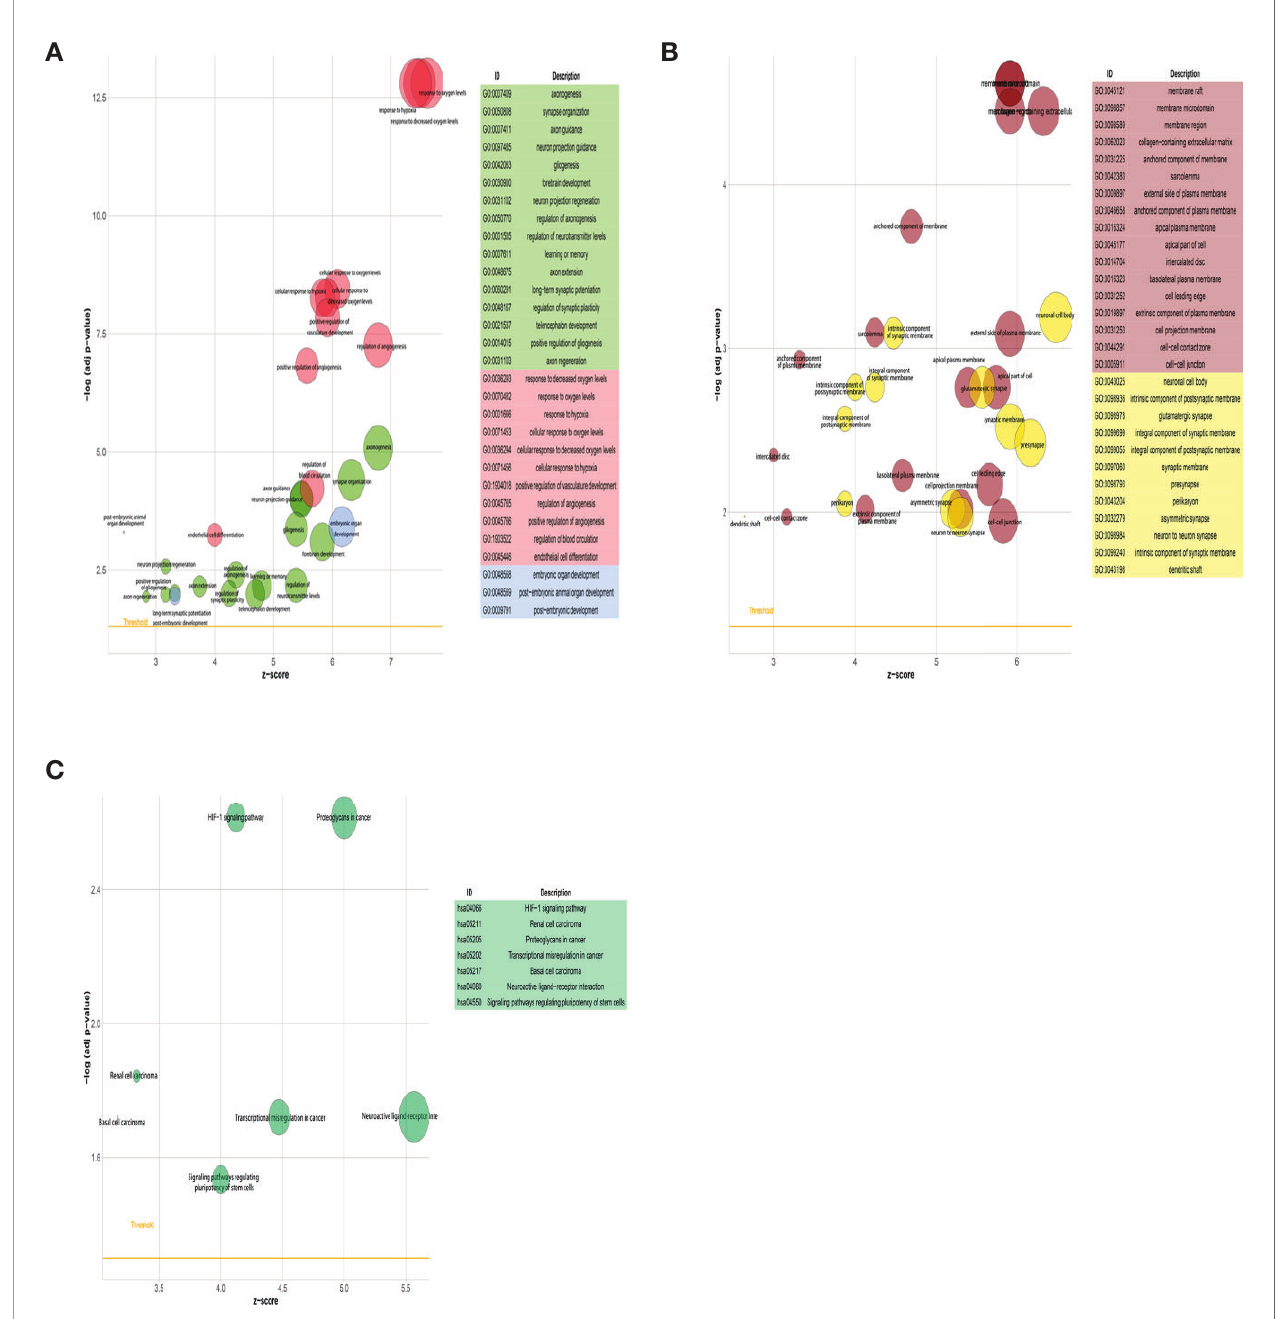
FIGURE 2 | GO and KEGG signaling pathways enrichment analysis of NCI-H209 co-cultured with HBMECs. (A, B) Enrichment analysis of BP and CC categories in GO database. (C) Signaling pathways in KEGG database enrichment analysis. The p - and q -values of the enriched terms as shown in the plot were both